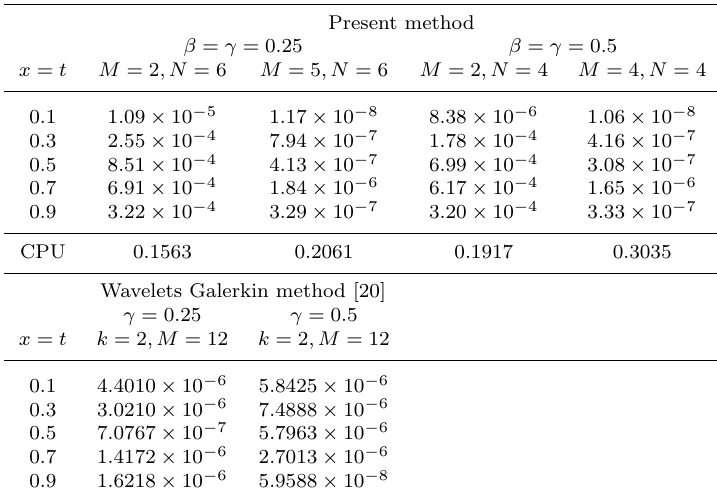
of this example is u ( x, t ) = exp( x ) t 1+ γ . We implement the suggested method for different values of M, N, β, γ on the interval [0 , 1] × [0 , 1] in Table 7.